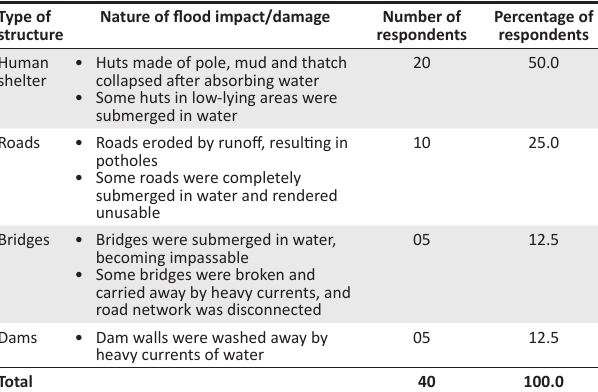
TABLE 1: Type of structures impacted by floods in the built environment ( N =